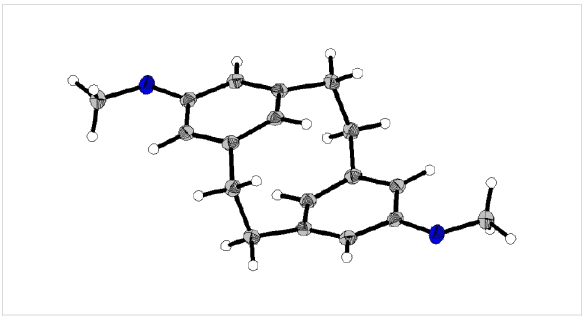
Figure 4: X-Ray structure of 8c with thermal ellipsoids drawn at 50% probability